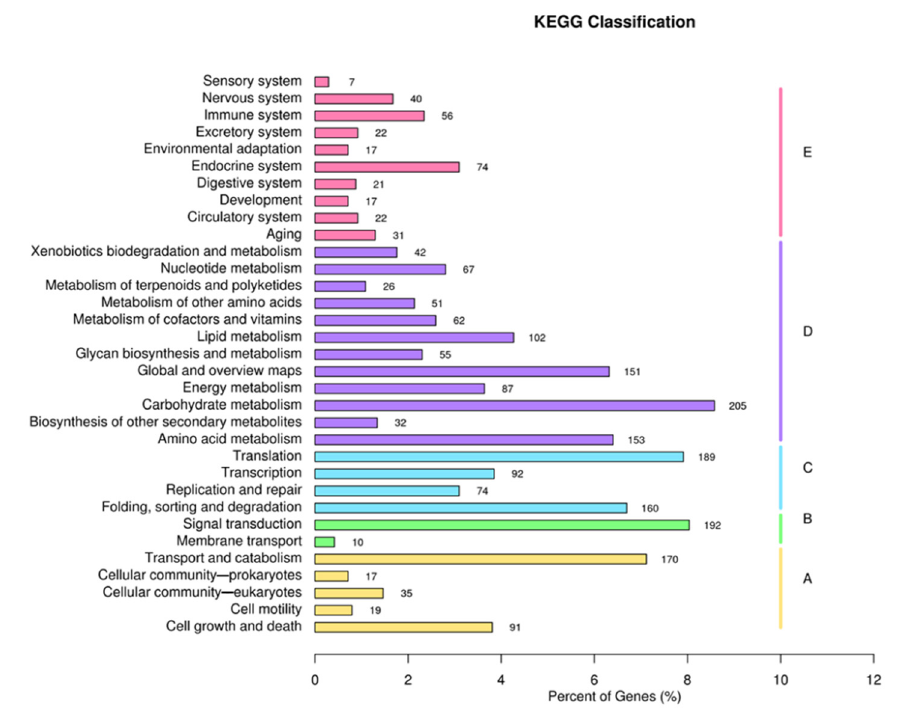
Figure 4. KEGG classification of P. tuoliensis transcriptome into functional groups. For KOG annotation, 2442 unigenes were annotated for the P . tuoliensis transcrip- tome. These unigenes were assigned to 25 categories. Among them, “General function